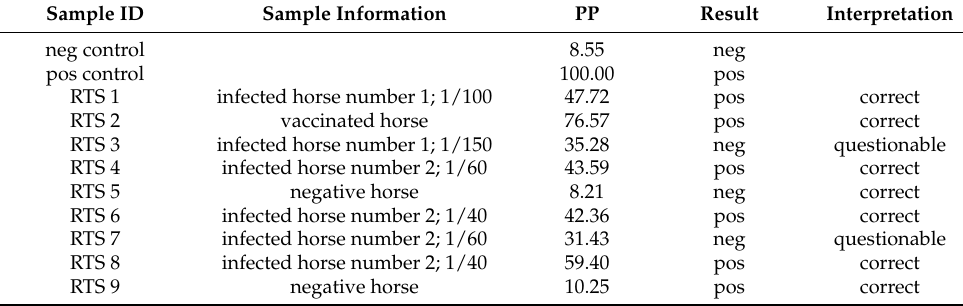
Table 3. Test results of ring trial samples in HeV-G ELISA. When applying the cut-off PP values based on ROC analysis with the highest combined DSe and DSp of 40, two dilutions of positive serum samples were identified as questionable and would be repeated by Western Blot or IF